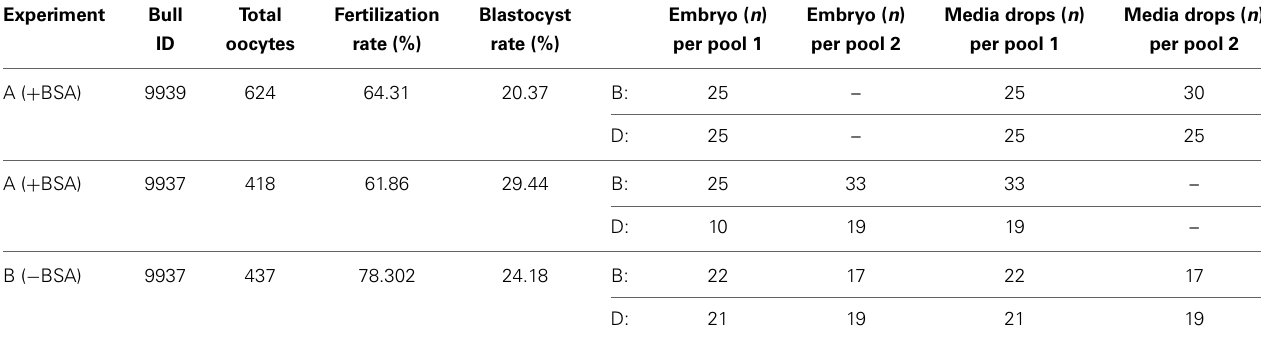
Table 1 | Bovine embryo development and pool design.